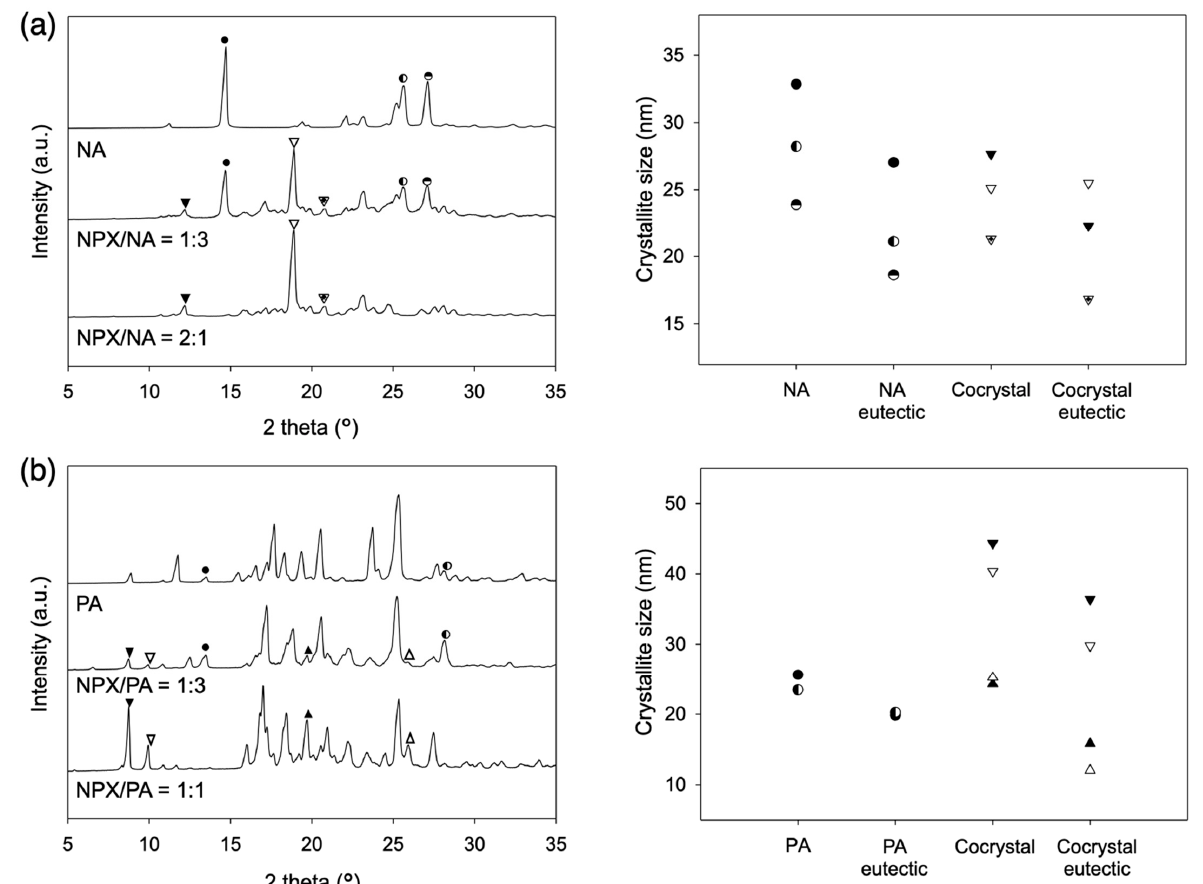
Figure 6. XRD patterns of the eutectics compared with neat cocrystals/coformers and the calculated crystallite size: ( a ) NPX/NA; ( b ) NPX/PA.